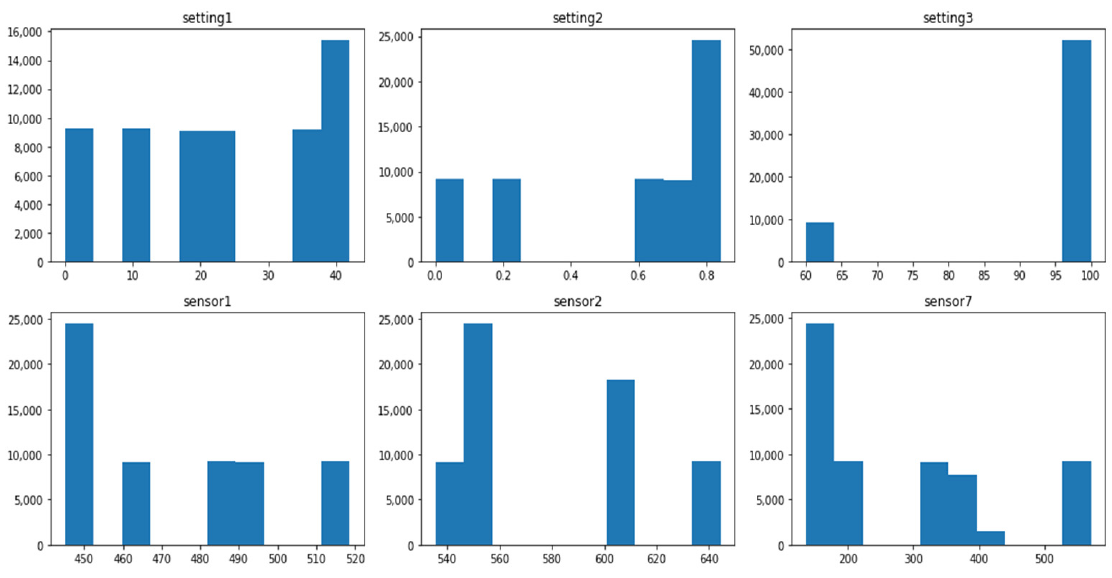
Figure 4. FD004_Train—distribution of selected variables.